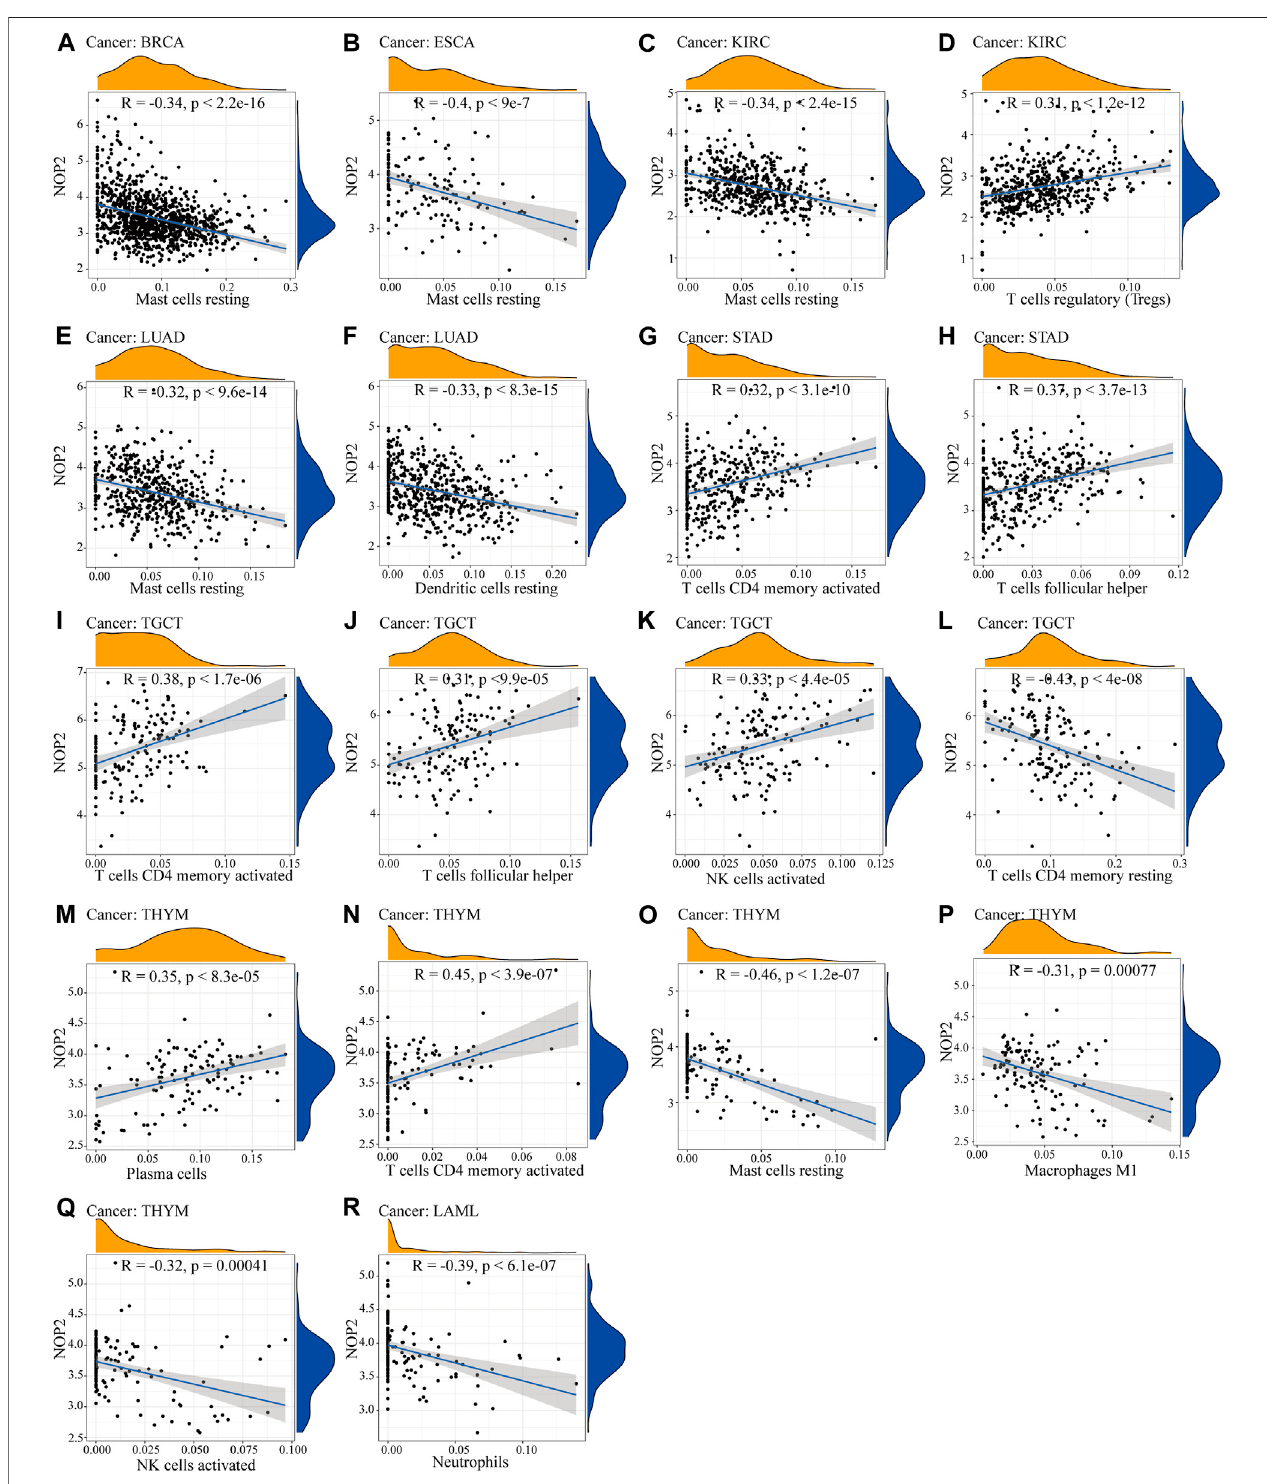
FIGURE 5 | Correlation between NOP2 expression and immune cell in fi ltration. (A – C) Correlation between NOP2 expression and mast cells resting in BRCA (A) , ESCA (B) , and KIRC (C) . (D) Regulatory T cells in KIRC. (E) Mast cells resting in LUAD. (F) Dendritic cells resting in LUAD. (G – H) T-cell CD4 memory activated (G) and T-cellfollicularhelper (H) inSTAD. (I – Q) TheT-cellCD4memoryactivated (I) ,T-cellfollicularhelper (J) ,NKcellsactivated (K) ,T-cellmemoryresting (L) ,plasmacells (M) , T-cell CD4 memory activated (N) , mast cells resting (O) , macrophage (P) , and NK cells activated (Q) in THYM. (R) Neutrophils in LAML.